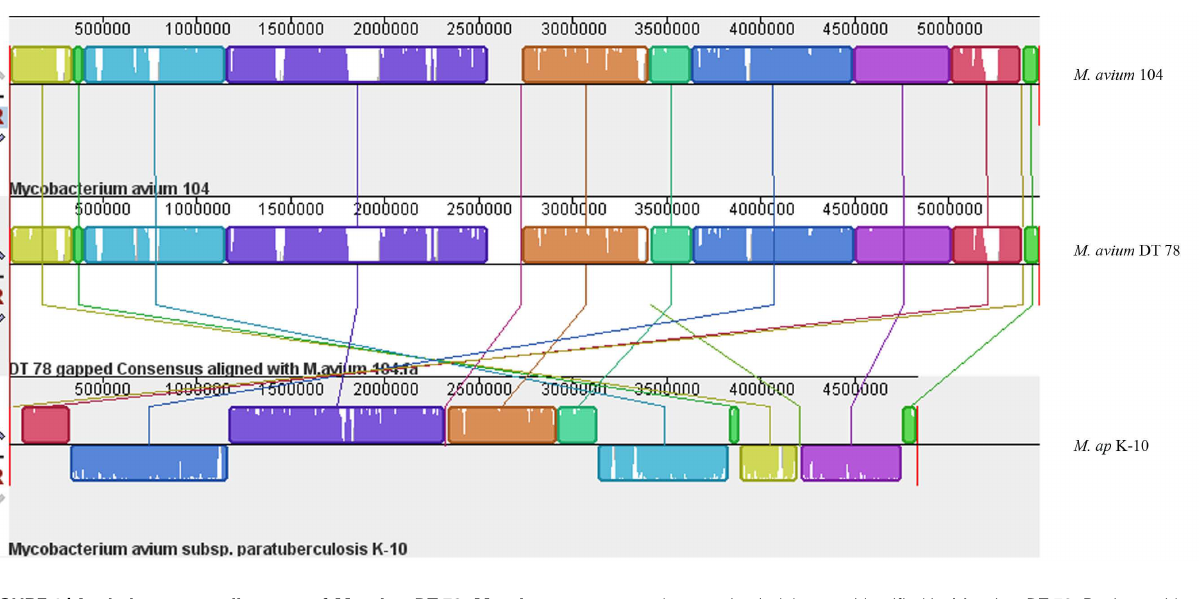
seven large region Indels were identified in M. avium DT 78. Regions with the same color indicate high similarity and connected by same color bars. The genomes were drawn to scale based on the reference M. avium 104